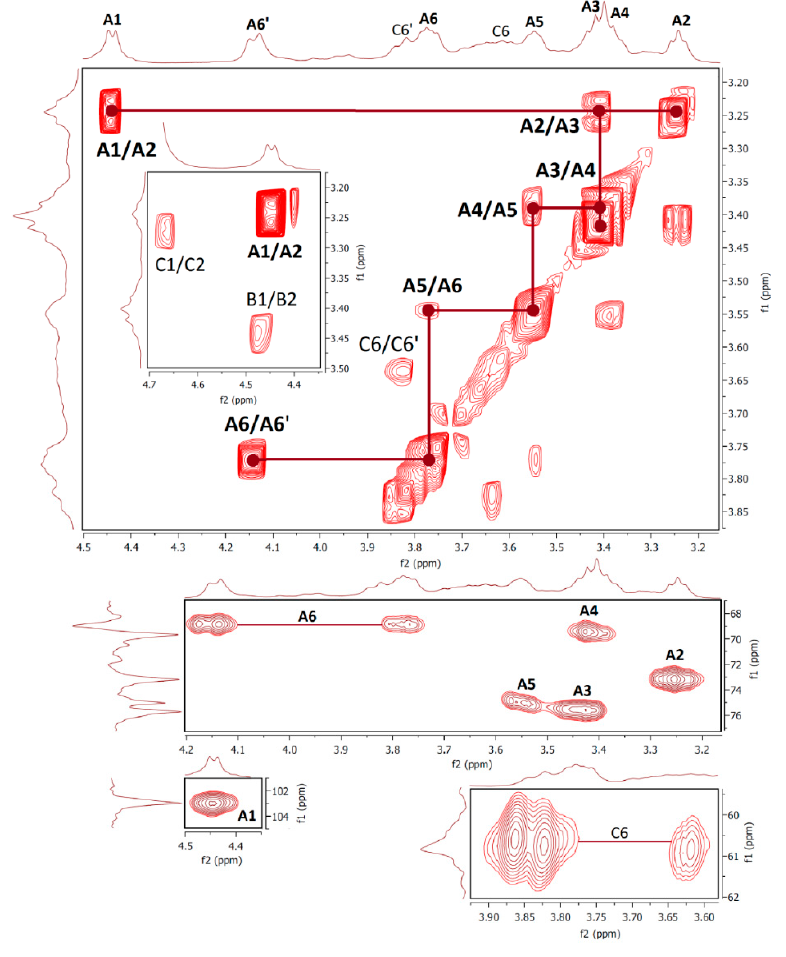
Molecules 2019 , 24 , x FOR PEER REVIEW Figure 4. The 1 H, 1 H COSY (top) and 1 H, 13 C HMQC (bottom) spectra of fraction F2 .